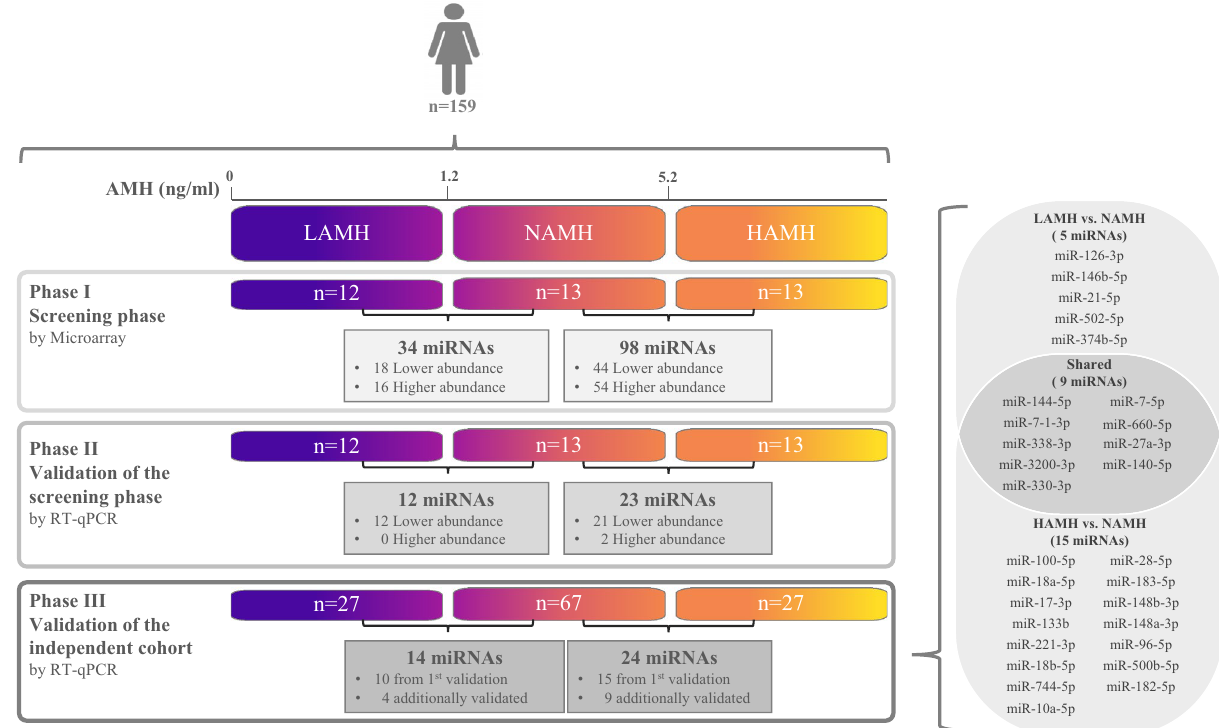
Figure 1. Workflow chart showing the number of women enrolled and the number and regulation of the detected miRNAs by microarray and RT-qPCR